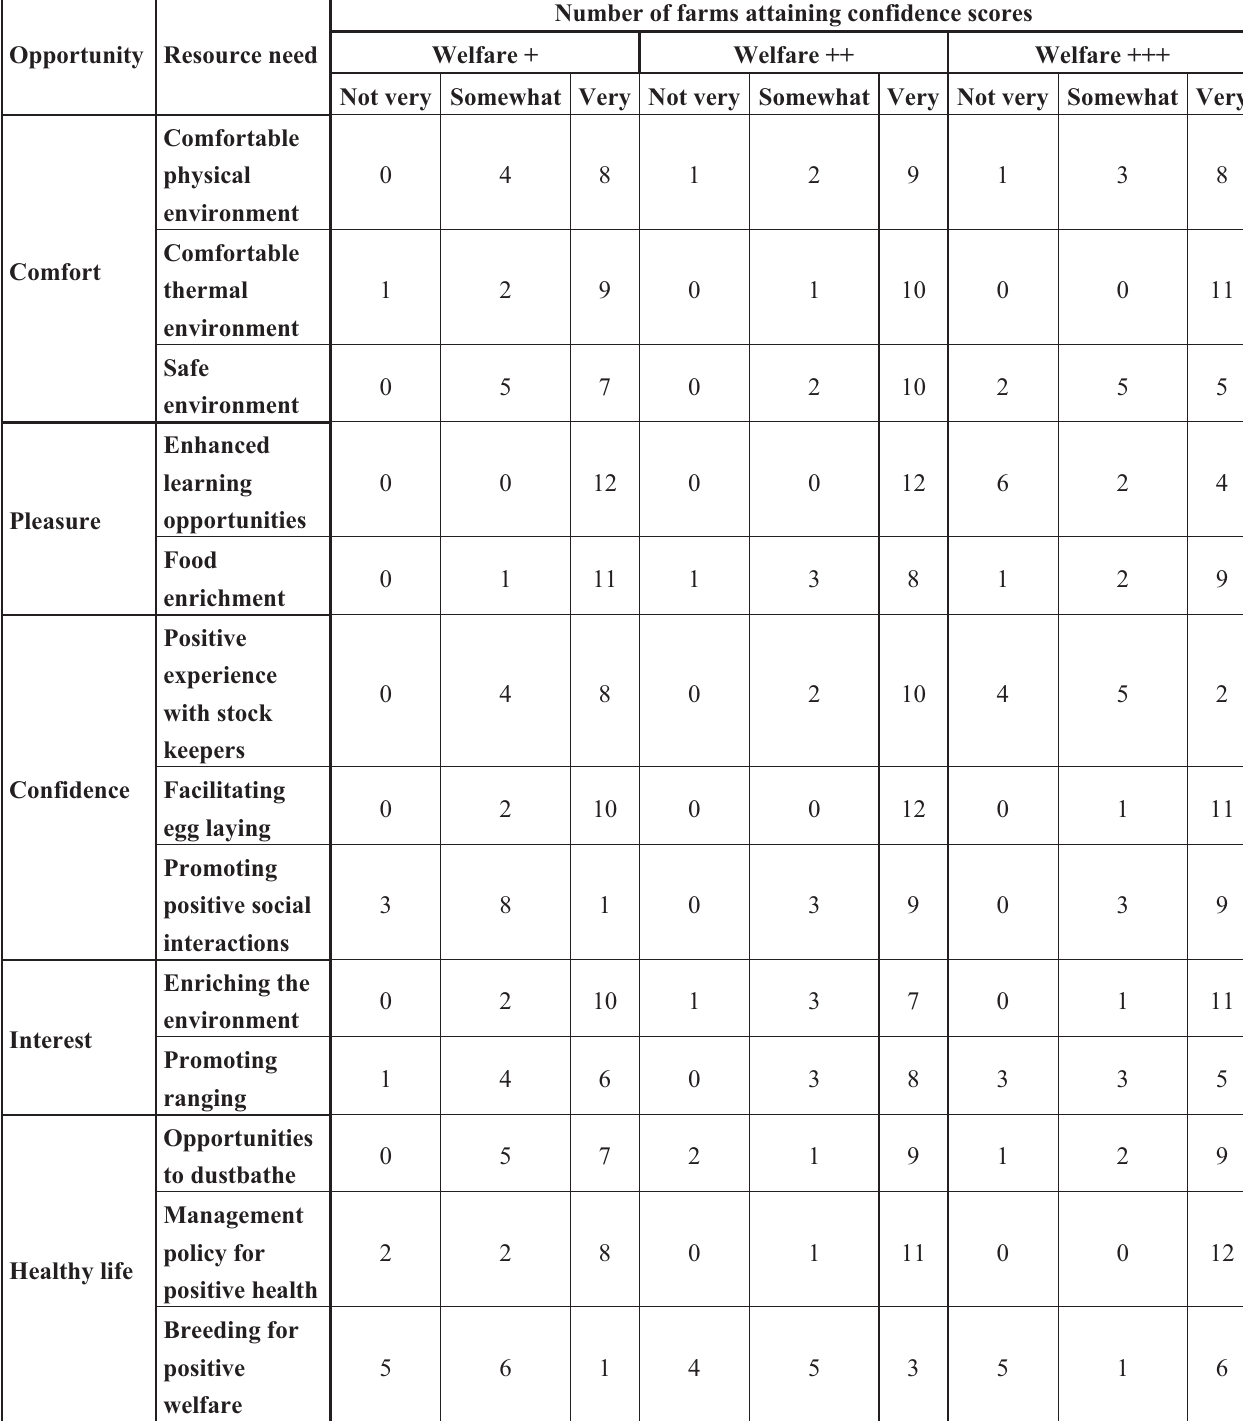
Table 3. Confidence scores in assigning ‘good life’ scores (number of farms), obtained during assessment using the ‘good life’ resource tiers. Opportunity Resource